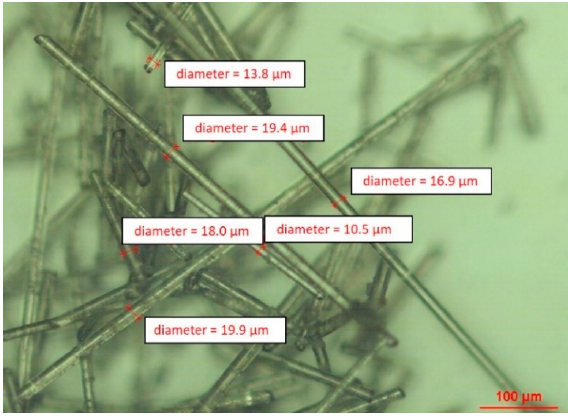
Figure 1. Milled recycled BMFs.